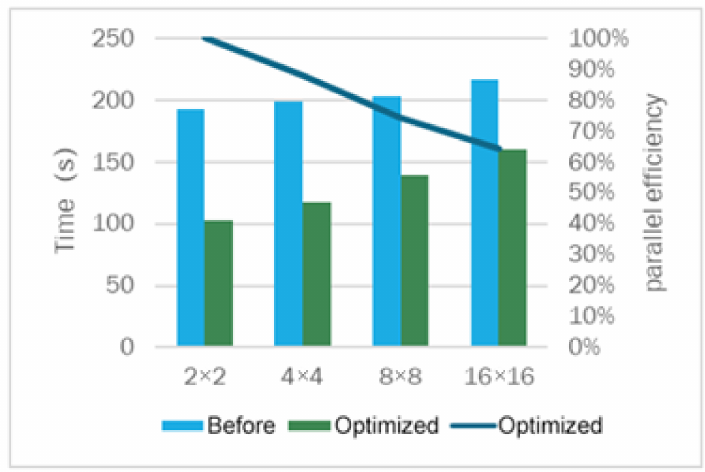
Figure 9. Extended test performance graph for overlapped